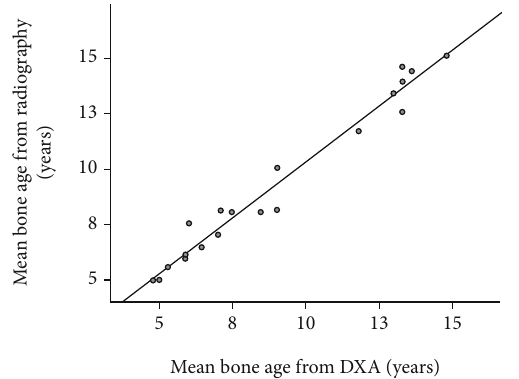
Figure 3: The mean of skeletal age for MRI and radiographs when plotted against line of